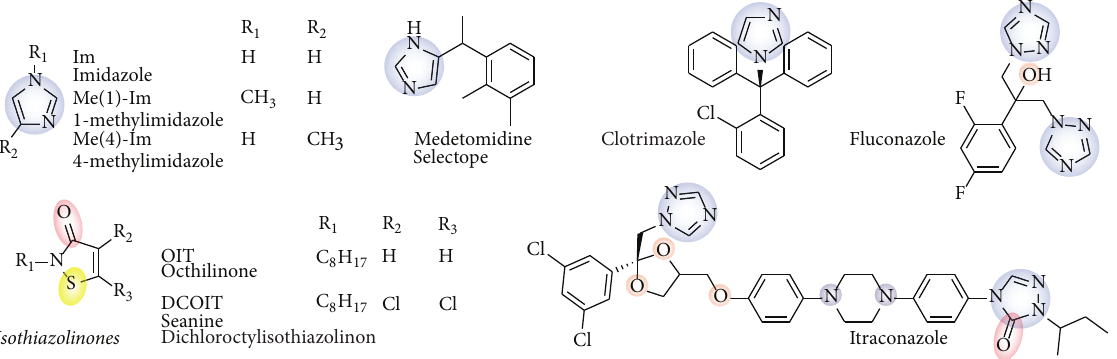
Scheme 1: Molecular structure, names, and abbreviations of polymers used for azole coordination and low molecular weight imidazole containing substances and five-membered nitrogen heterocyclic biocides investigated in this review. Potential nitrogen coordinating borderline ligands (imidazole, triazole) or hard ligands (amines), oxygen coordinating hard ligands, and sulphur coordinating soft ligands are marked with blue, purple, red, and yellow, respectively. Weak ligands such as organic halides have not been marked.